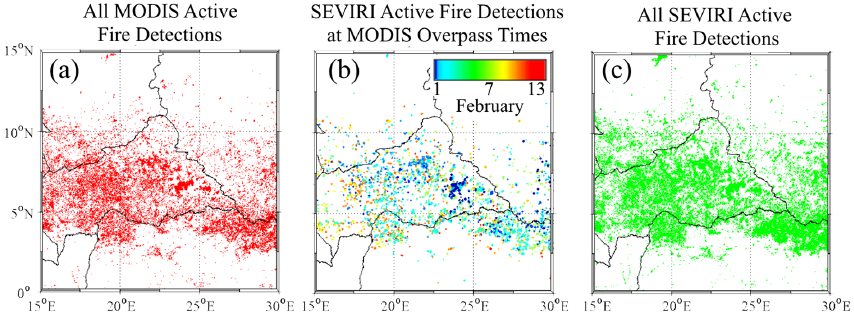
Figure 19. Active fire detections made across a 15 ◦ × 15 ◦ region covering the Central African Republic during a 2-week window (1– 13 February 2004), as detected from (a) the MOD14/MYD14 active fire products, (b) SEVIRI data and the FTA algorithm within ± 6min of the MODIS overpass, and (c) all SEVIRI data. In (b) , the detected active fire pixels are coloured by day of detection and it is apparent that fires appear potentially larger and are detected earlier in the east, somewhat matching the detailed analysis presented in Freeborn et al. (2004a, c).